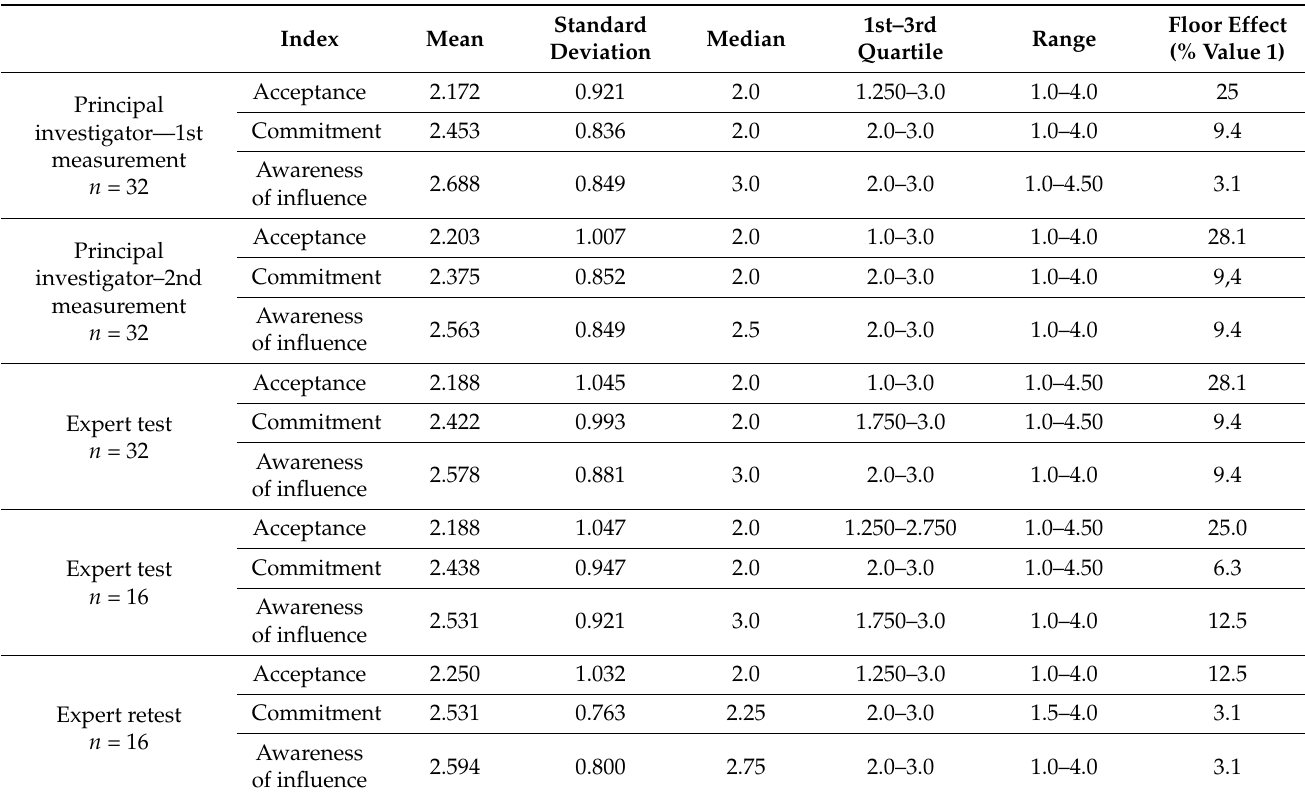
Table 2. Description of the data obtained in the evaluations carried out by the principal investigator (first and second measurements), those obtained by the expert evaluator and those obtained in the test and